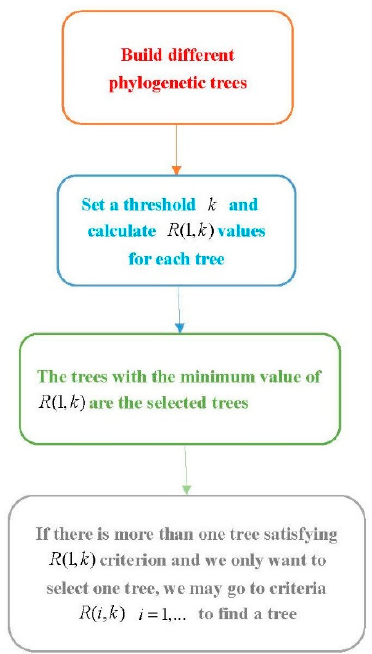
Figure 2. The flowchart of Procedure 1.